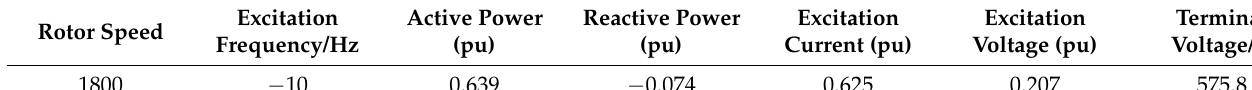
Table 7. The change in rotor speed at a given power at a wind speed of 12 m/s.